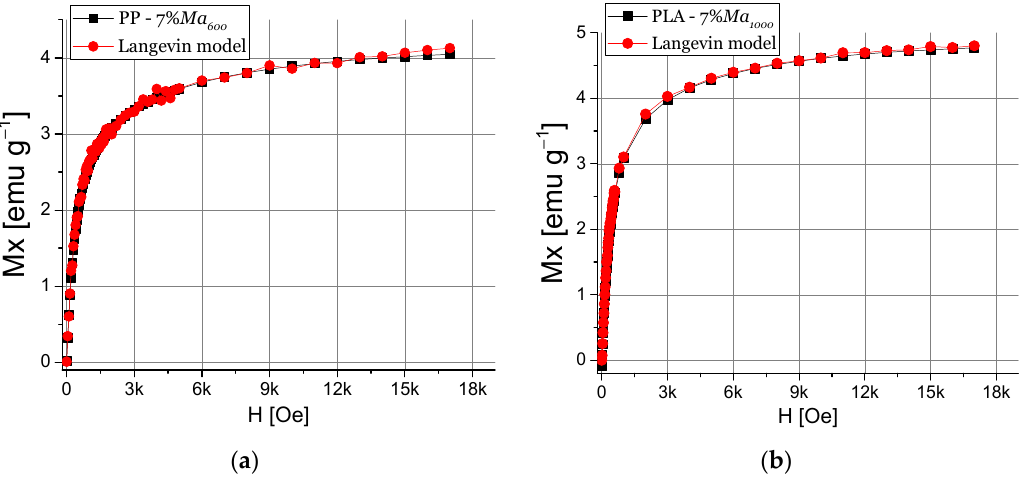
Figure 9. Langevin model for magnetic properties of PP-TrGO:Fe 3 O 4 ( a ) and PLA-TrGO:Fe 3 O 4 ( b ).